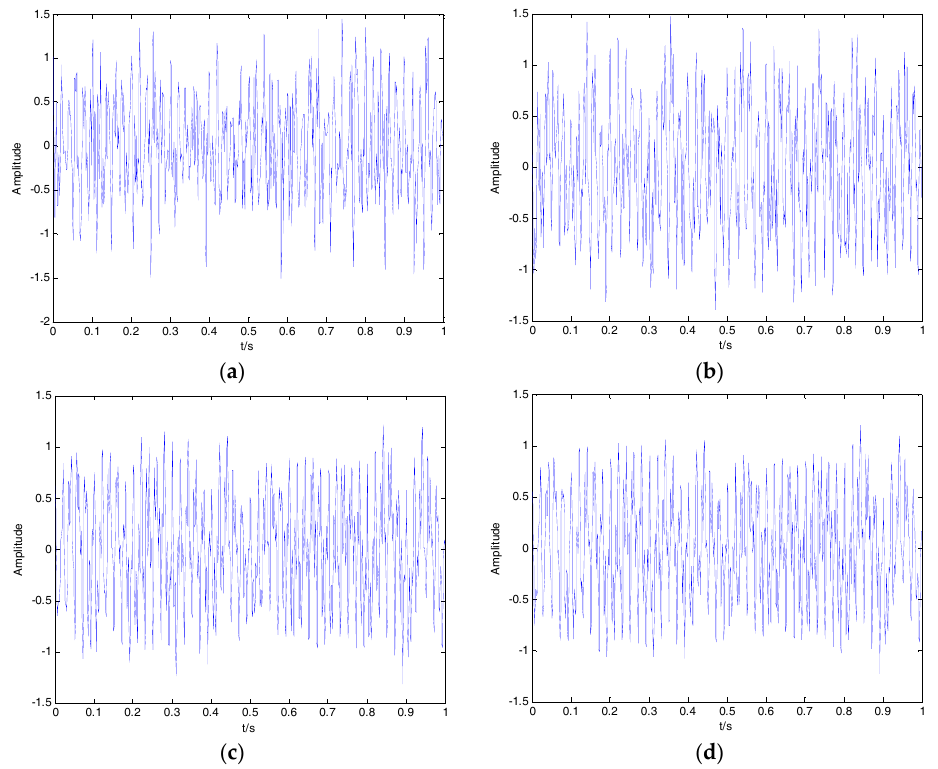
Figure 8. The denoising results of EMD, EEMD, VMD and 2VMD for the noisy signal. ( a ) EMD; ( b ) EEMD; ( c ) VMD; ( d ) 2VMD. Table 5. The SNR and RMSE for EMD, EEMD, VMD and 2VMD denoising.